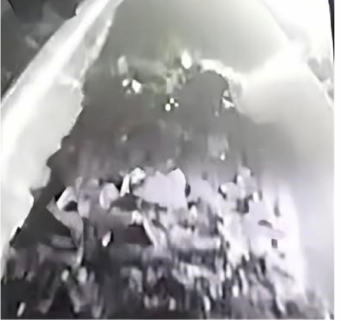
Figure 1. Monitoring image of belt conveyor in the coal